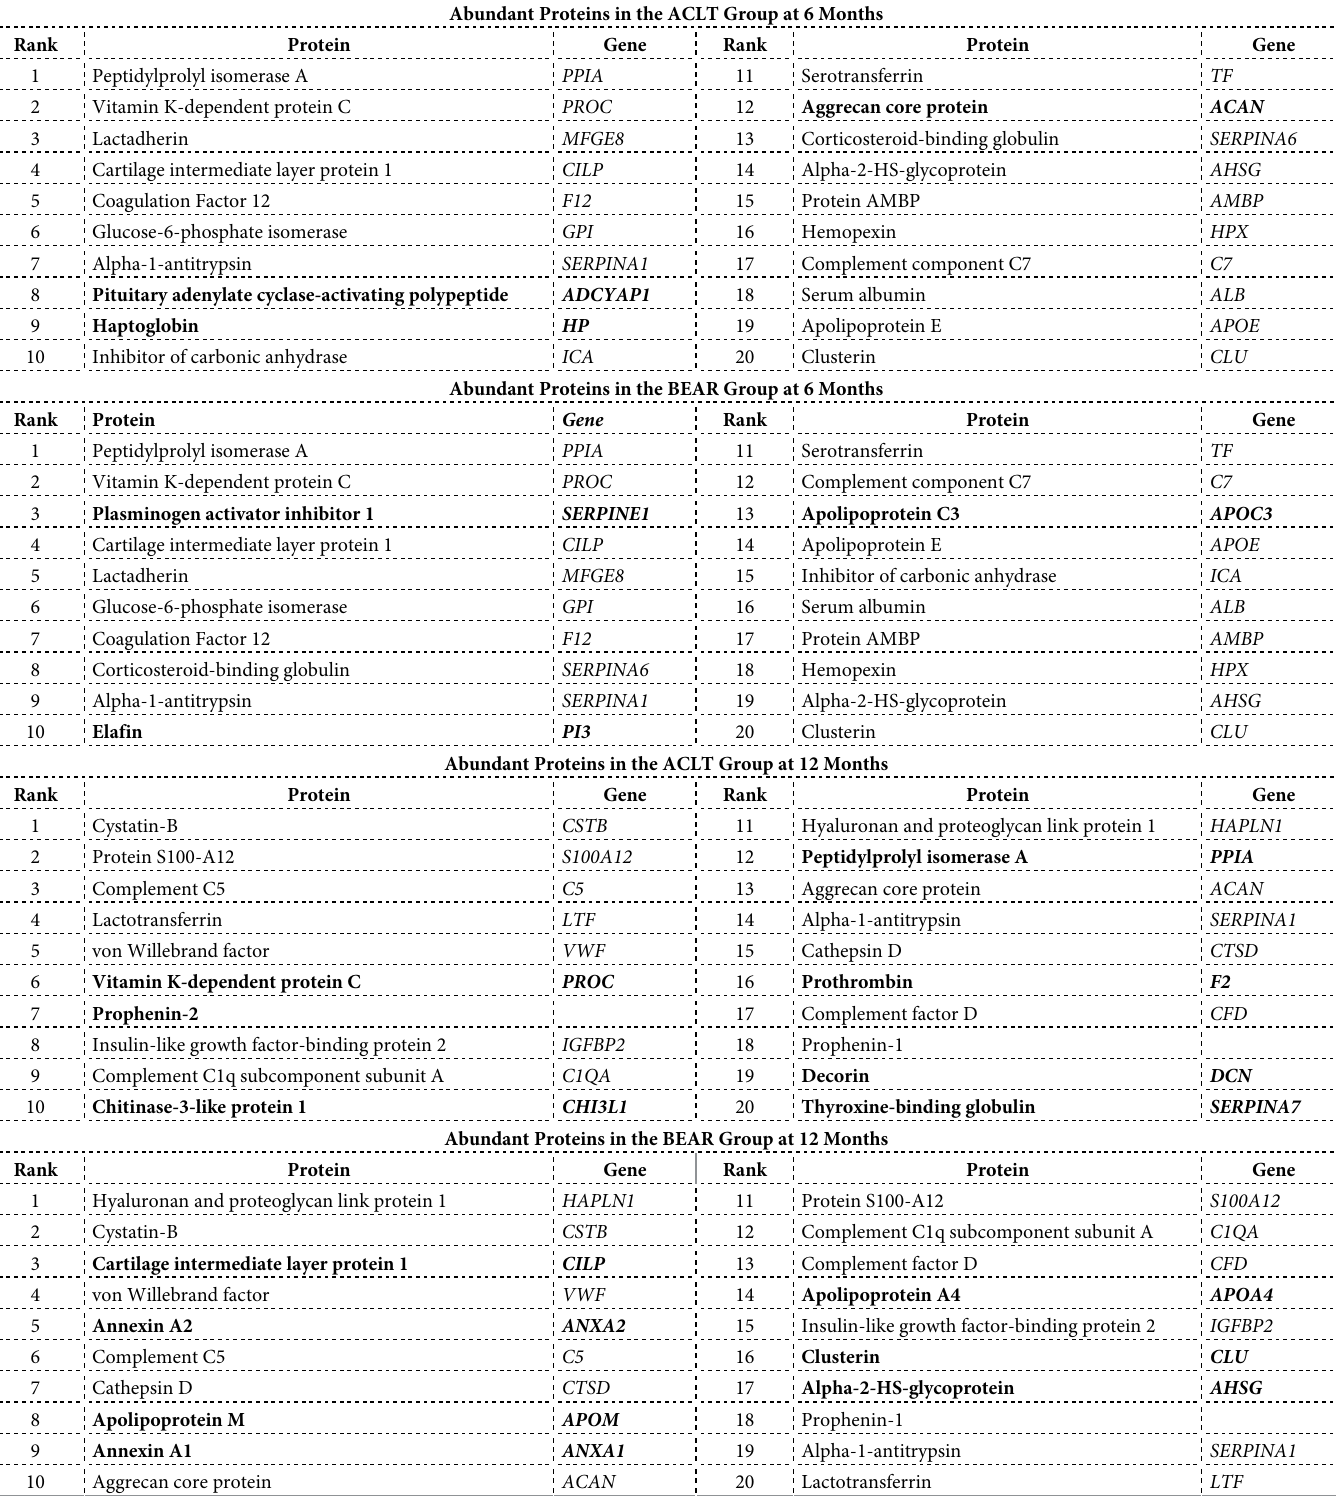
Table 1. Top 20 most abundant secreted proteins detected in the synovial fluid in each surgical group. The uniquely abundant proteins in each group are highlighted in bold. Abundant Proteins in the ACLT Group at 6